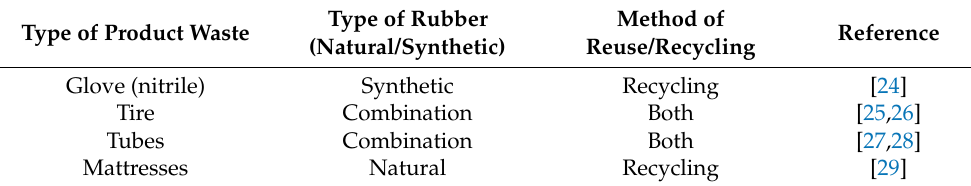
Table 1. Review of the current usage of rubber